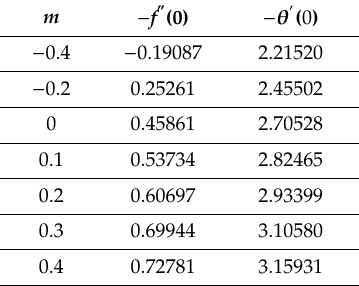
Table 4. The variation of the component of C f and Nu with m ( φ = 0.02, β =